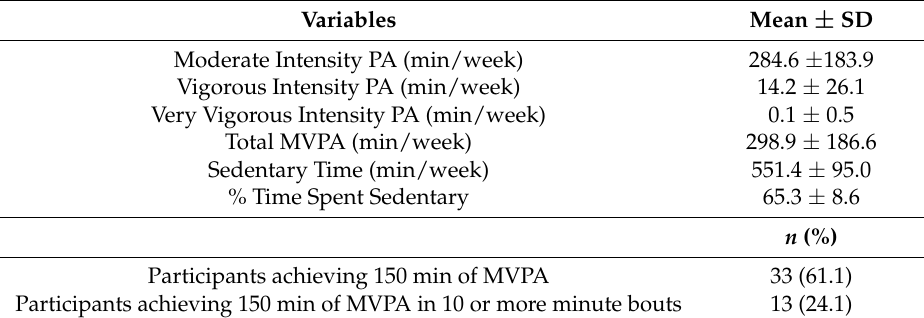
Table 3. Summary of accelerometery measured physical activity in 54 South Asian men with valid accelerometery